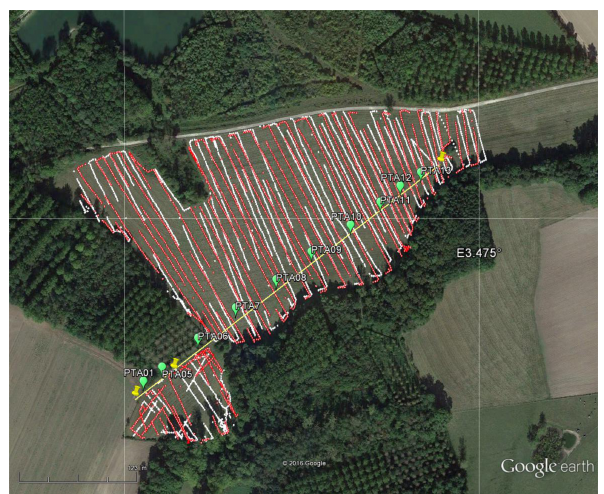
Figure 3. Map of the surveyed area, showing the locations of the VCP (red) and HCP (white) measurements (GPS issues explain the holes within the lines). The reference (ERI) profile, recorded with a Wenner–Schlumberger configuration using 1m electrode spacing between 0 and 350m, and a 0.5m electrode spacing between 350 and 401.5m, is indicated by the yellow line. As green dots, the lo- cations of the hand auger